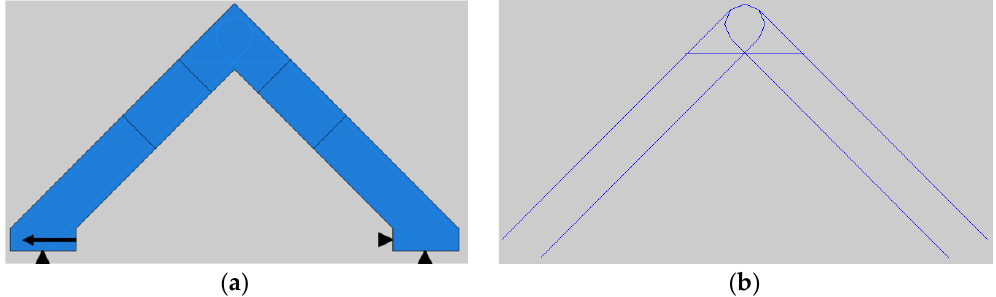
Figure 31. Boundary conditions ( a ) and reinforcement ( b ) of modeled RV9 specimen.